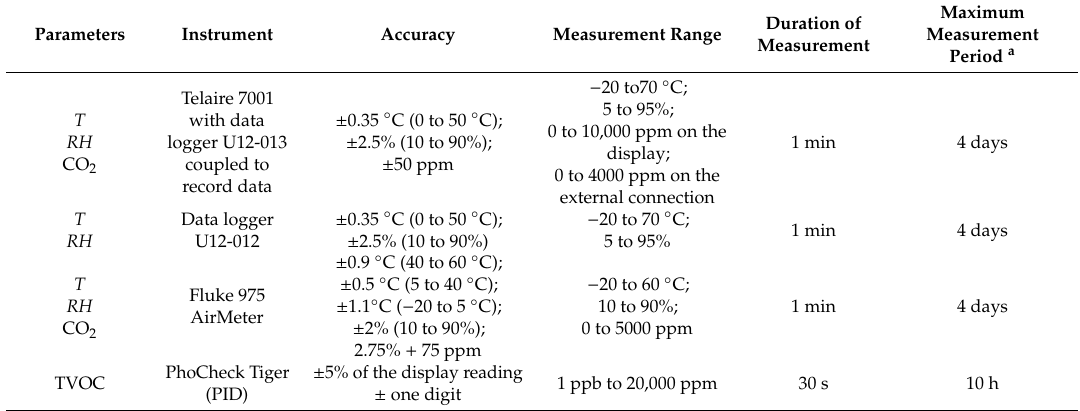
Table6. Viseu: parameters,technicalcharacteristicsoftheequipmentused,andconditionsofmeasurement. Parameters